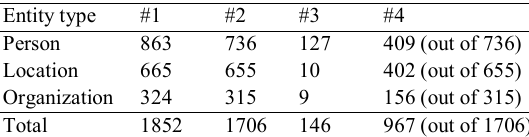
Table 1. Statistics of mentions in the datasets.